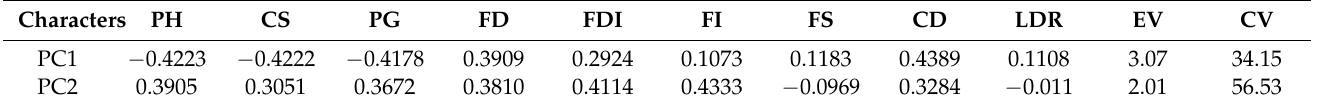
Table 2. Principal component analysis for input variable selection.